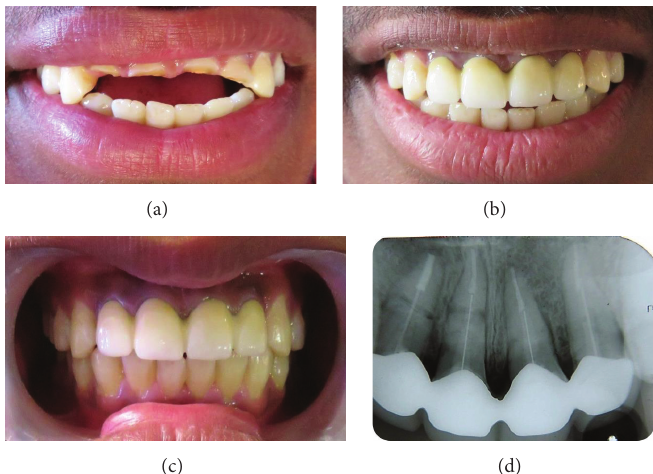
Figure 2: (a) Preoperative smile of the patient. (b) Postoperative smile. (c) Clinical photograph after one year of follow-up. (d) Postoperative radiograph after one year of